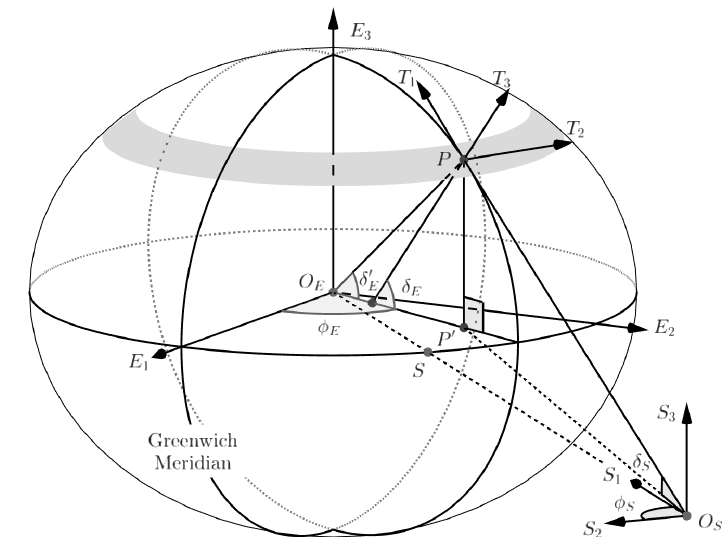
Figure 4. Coordinates’ conversion between Earth and geostationary satellites. The axes ( E 1 , E 2 , E 3 ) define a geocentric Cartesian coordinate system with E 1 passing through the Greenwich Meridian. The pair ( δ E , φ E ) indicates the geographic latitude/longitude coordinates of a point P on Earth’s surface, while δ (cid:48) indicates the corresponding geocentric latitude. The axes ( T 1 , T 2 , T 3 ) define the E topocentric Cartesian system at P , with T 1 pointing to local north and T 3 pointing to the geodetic zenith. The idealized satellite sensor is located at O S , and the axes ( S 1 , S 2 , S 3 ) define a satellite-centered Cartesian system with S 1 pointing towards the center of Earth. As shown, the pair ( δ S , φ S ) denotes the elevation and the azimuth angles of P on the scanning plane. The sweep axis in this configuration (AHI) is “y”. In comparison, the elevation angle in the “x” sweep-axis configuration (ABI) is defined as the angle between the line O S P and the plane S 1 O s S 3 , while the azimuth angle is defined relative to S 3 in the plane S 1 O s S 3 . See the text for the